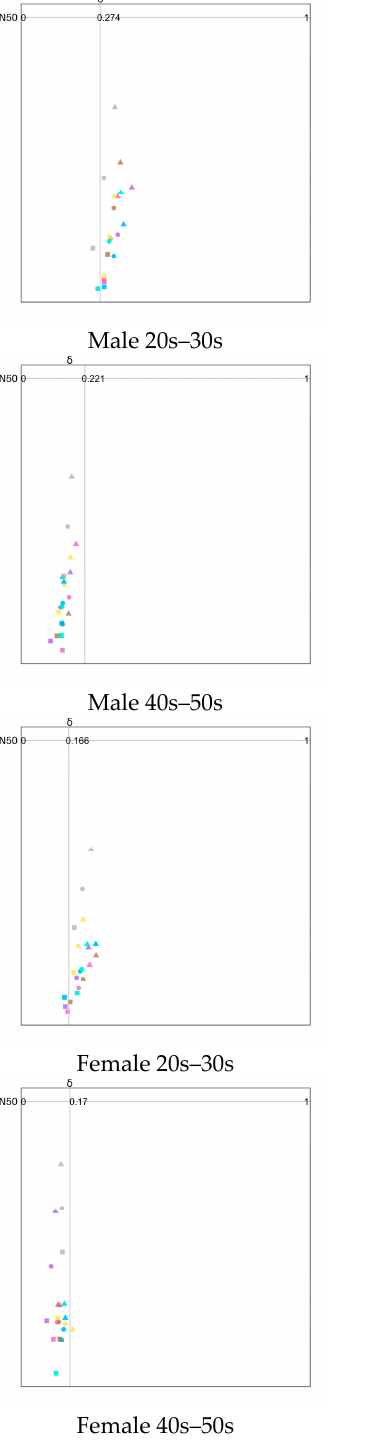
Figure 13. Emotion maps using pNN50 and δ wave divided by gender and generation. The left figures show the full-scale emotion maps. The right figures show the zoomed version of the emotion maps on the left for a closer observation of the plots. The dots with different colors indicate the different olfactory stimuli as shown in the legend (Figure